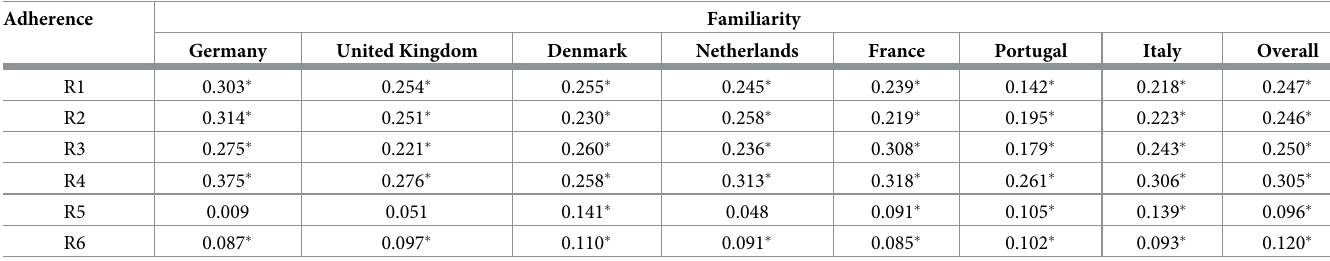
Table 4. Correlations between level of familiarity and level of adherence. Adherence